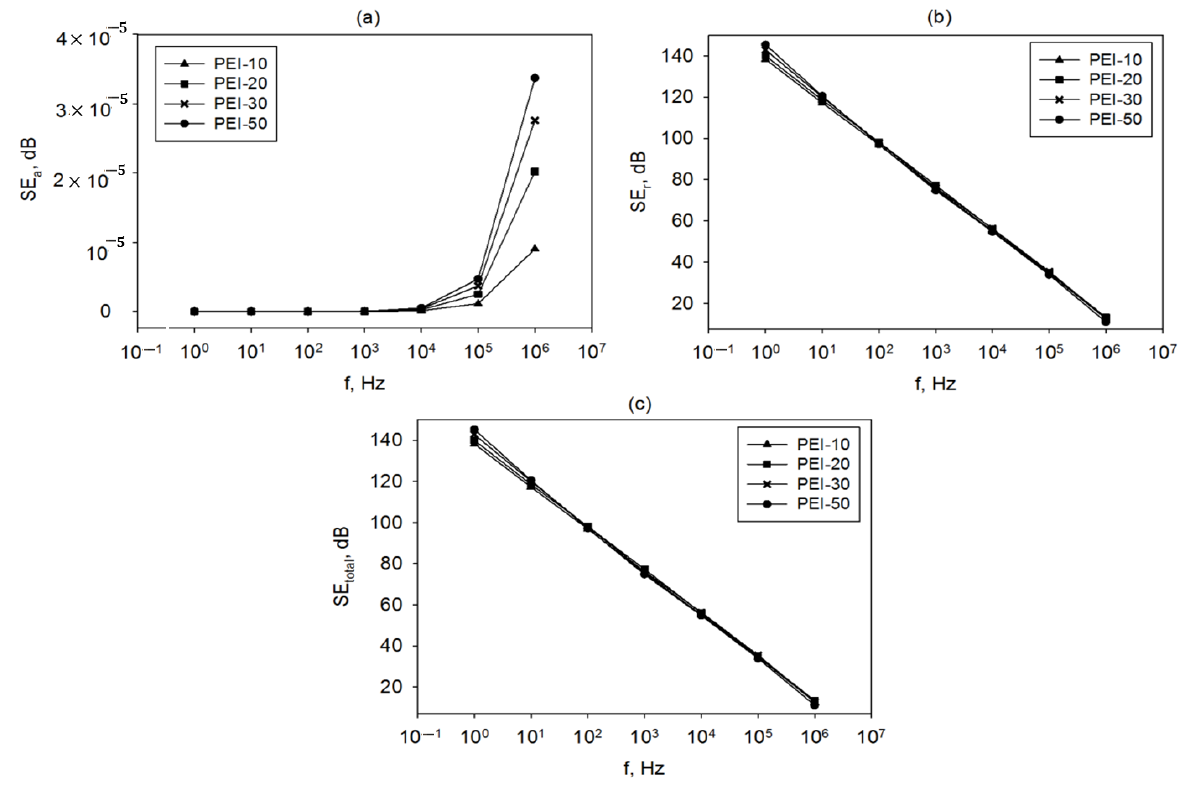
Figure 10. Shielding effectiveness by means of ( a ) absorption, ( b ) reflection, and ( c ) total shielding ability of the PEI/CoFe 2 O 4 films.